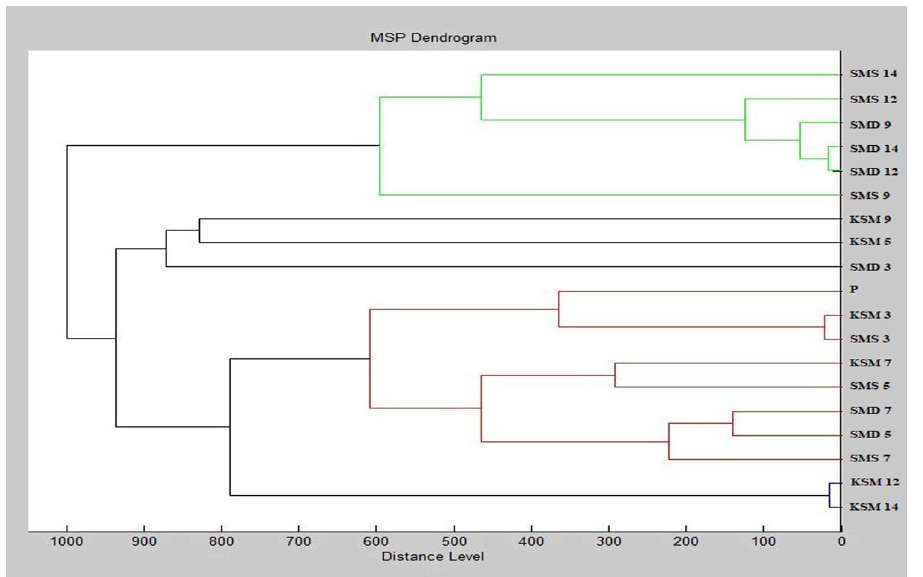
Figure 7: Dendrogram of S. maltophilia generated using MSP for the planktonic cells and all experimental groups. Abbreviations: K, control; SM, Stenotrophomonas maltophilia ; S, glass; D, wood; P, planktonic